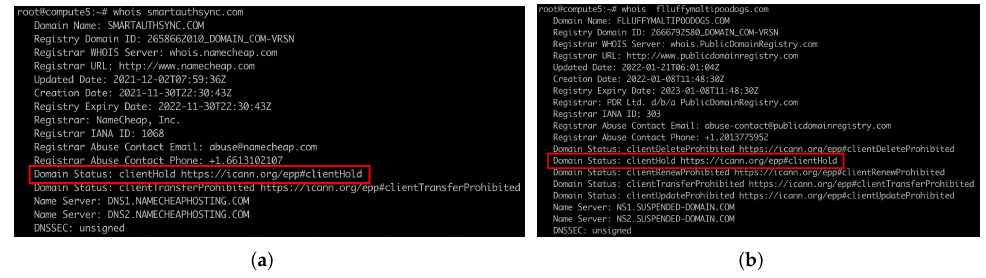
Figure 16. Registrars handle phishing domains. ( a ) Registrar NameCheap, Inc. (from the USA) handles phishing domain smartauthsync.com. ( b ) Registrar PDR Ltd. (from India) handles phishing domain